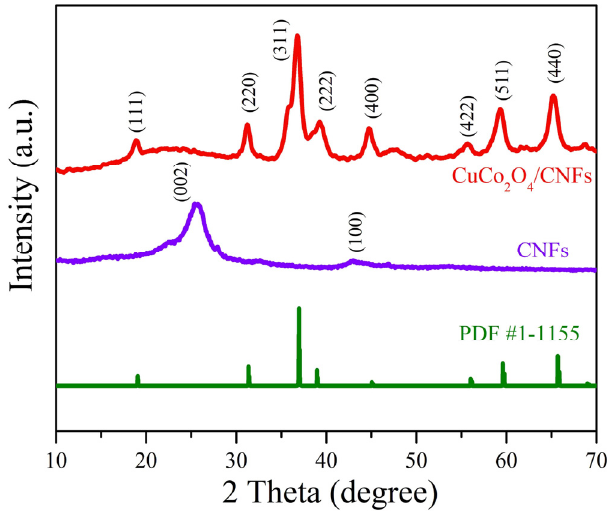
Figure 1. XRD patterns of pure CNFs and CuCo 2 O 4 @CNFs.